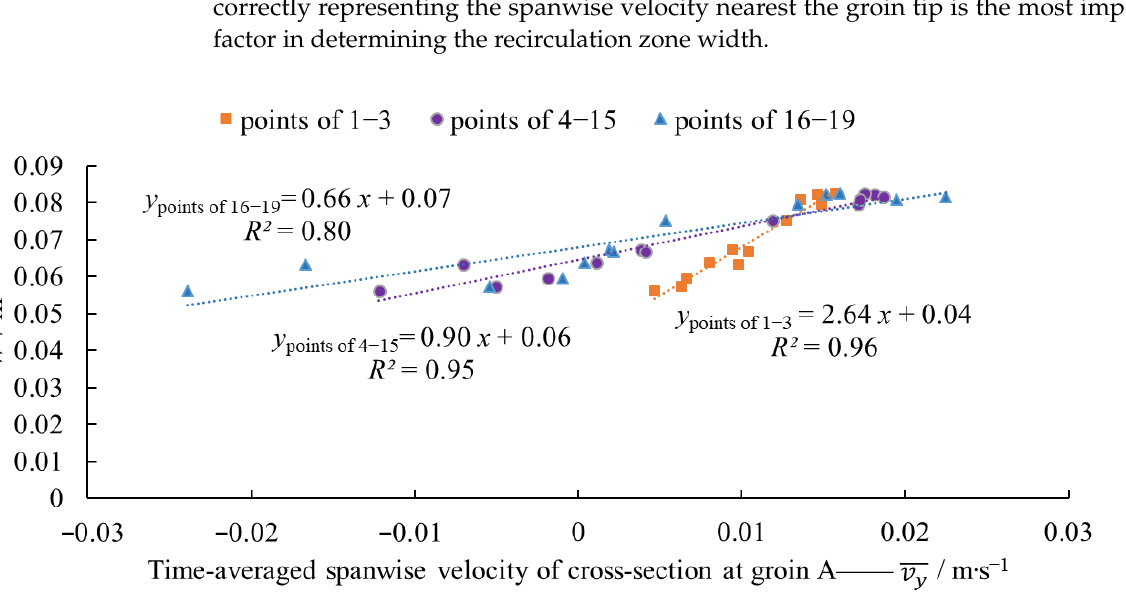
Figure 11. Relationship between the time-averaged spanwise velocity ( 𝑣 𝑦 ̅̅̅) of observed points along the cross-section through Groin A and the width of the recirculation zone ( W ) behind Groin A.